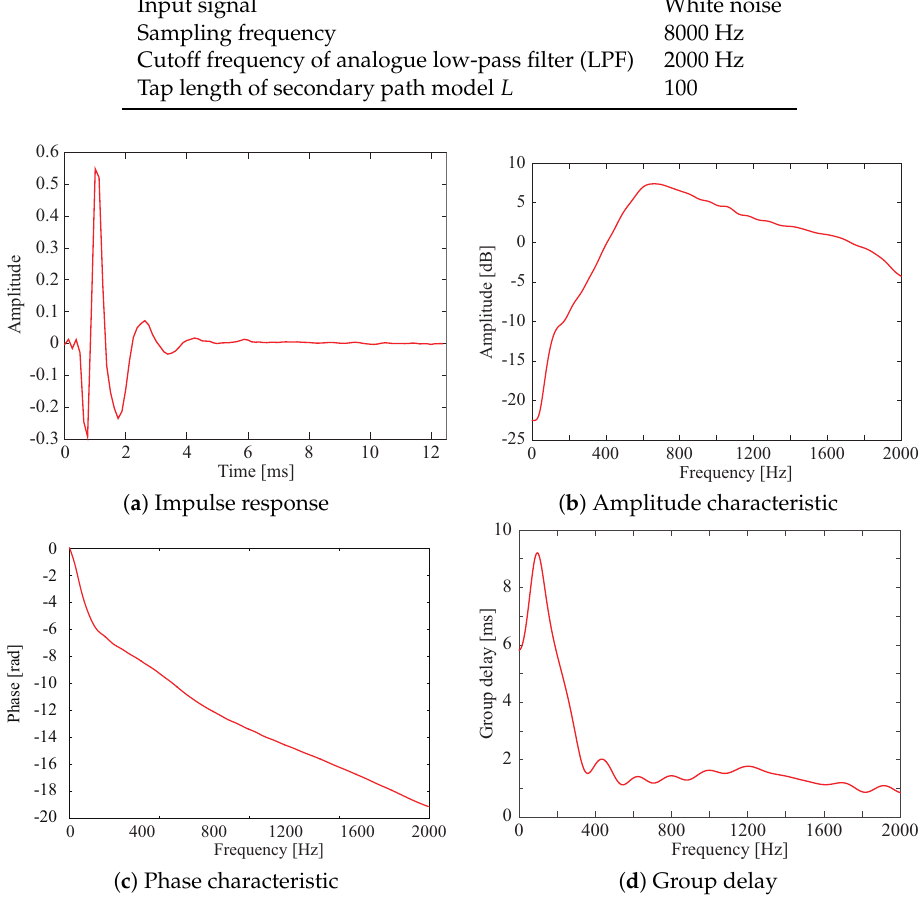
Figure 9. Impulse response and frequency response of the secondary